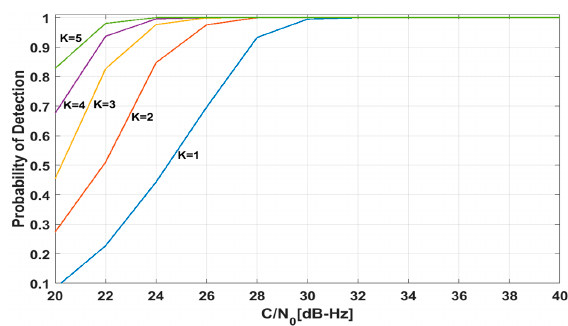
Figure 11. P d with respect to C/N 0 and K for the DM method (P fa = 0.001).